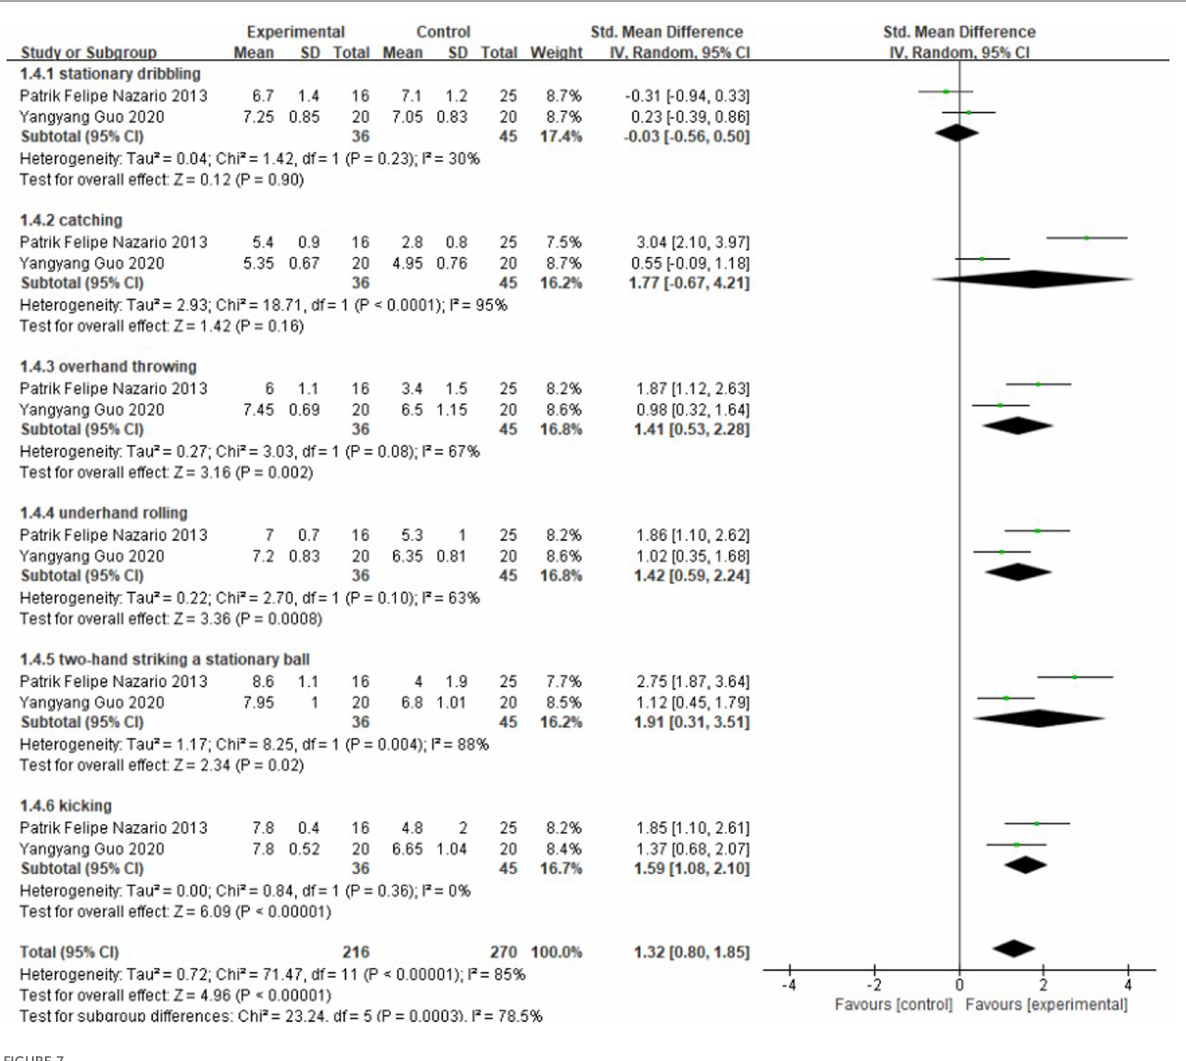
FIGURE 7 A meta-analysis of the results of object control was conducted for comparisons between the control and experimental